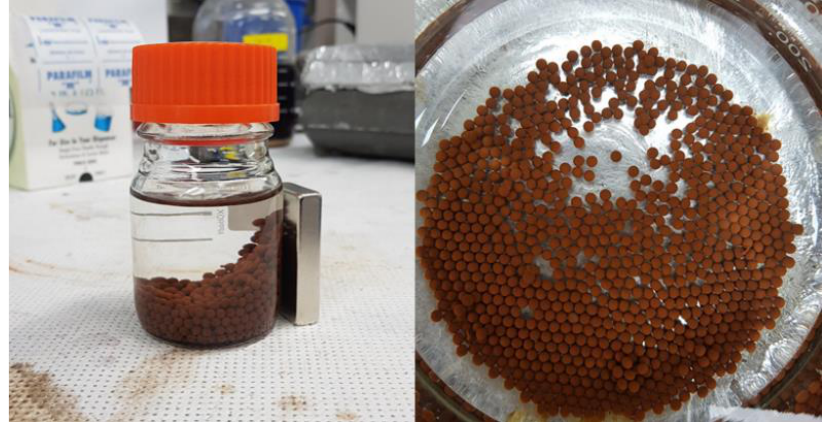
Figure 1. SCM beads under wet condition.